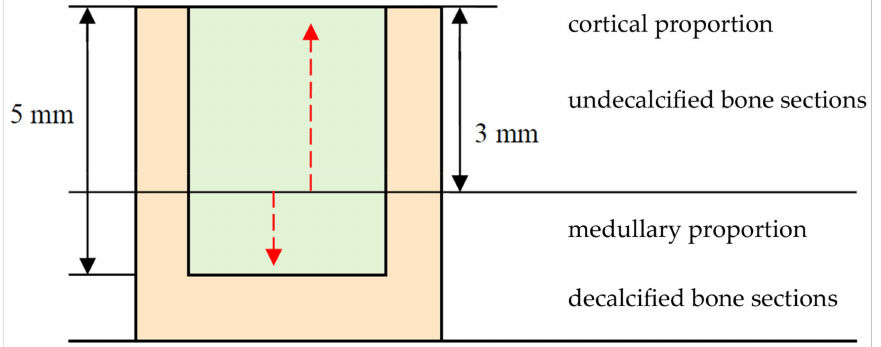
Figure 8. Assignment of the collected bone sample to the respective histologic evaluation method. The biomaterial remnant is expressed by light green. Bone is presented in light red